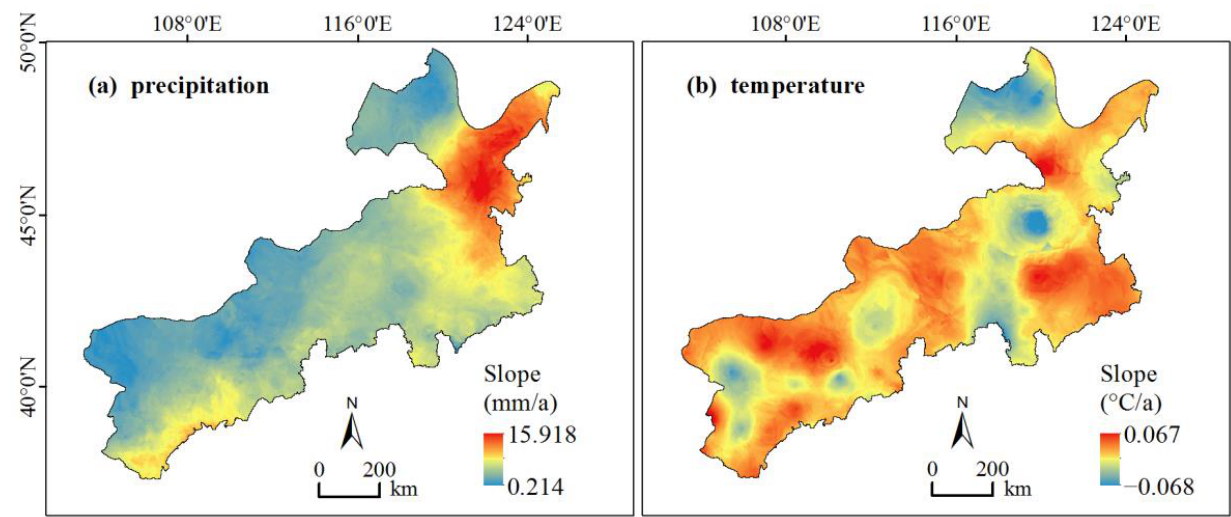
Figure 11. The slopes of changes in ( a ) precipitation and ( b ) temperature from 2000 – 2018.